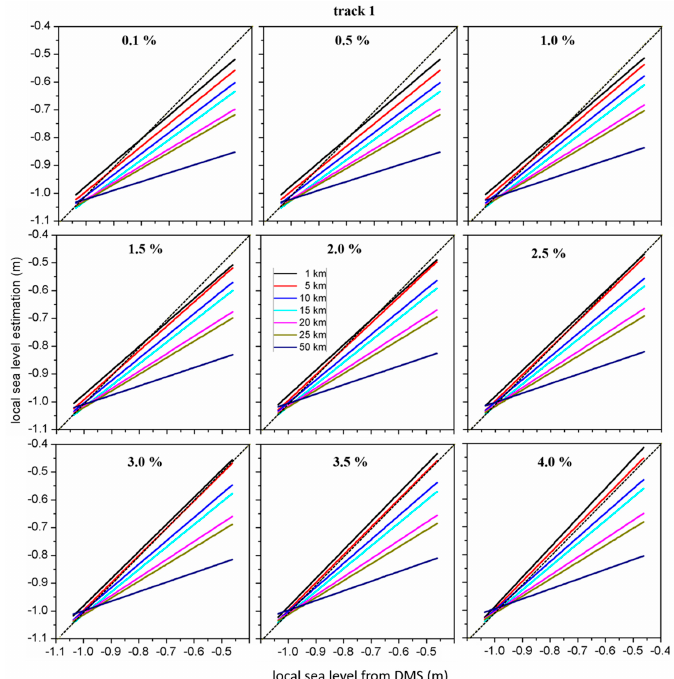
Figure 3. Linear fit lines of track 1 between retrievals from the lowest elevation method and those from the DMS method (ground truth) at 7 segment length scales: 1, 5, 10, 15, 20, 25, and 50 km, and 9 percentage scales: 0.1%, 0.5%, 1%, 1.5%, 2%, 2.5%, 3%, 3.5%, and 4%. The dashed line is the 1:1 line. All linear least square fits are statistically significant with greater than 95% confidence using an F